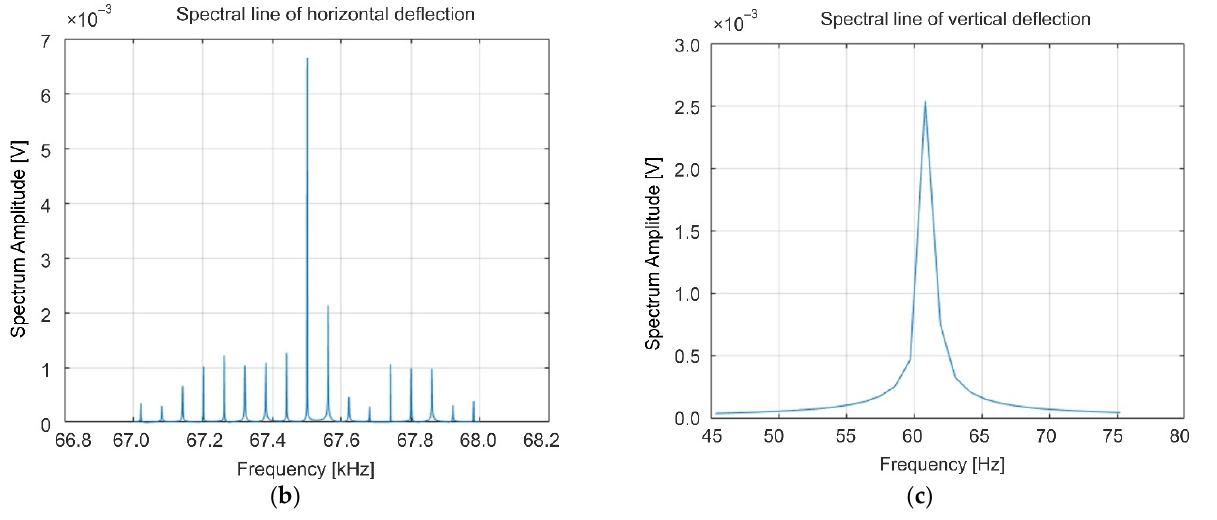
Figure 4. ( a ) Amplitude spectrum of the test signal (window of MS Word editor) and magnification of its fragments corresponding to the ( b ) horizontal and ( c ) vertical sync frequencies.